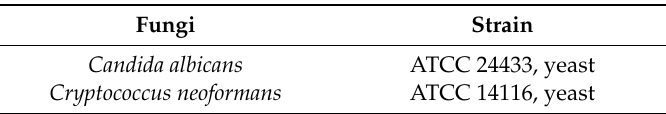
Table 6. Fungal test organisms used in this